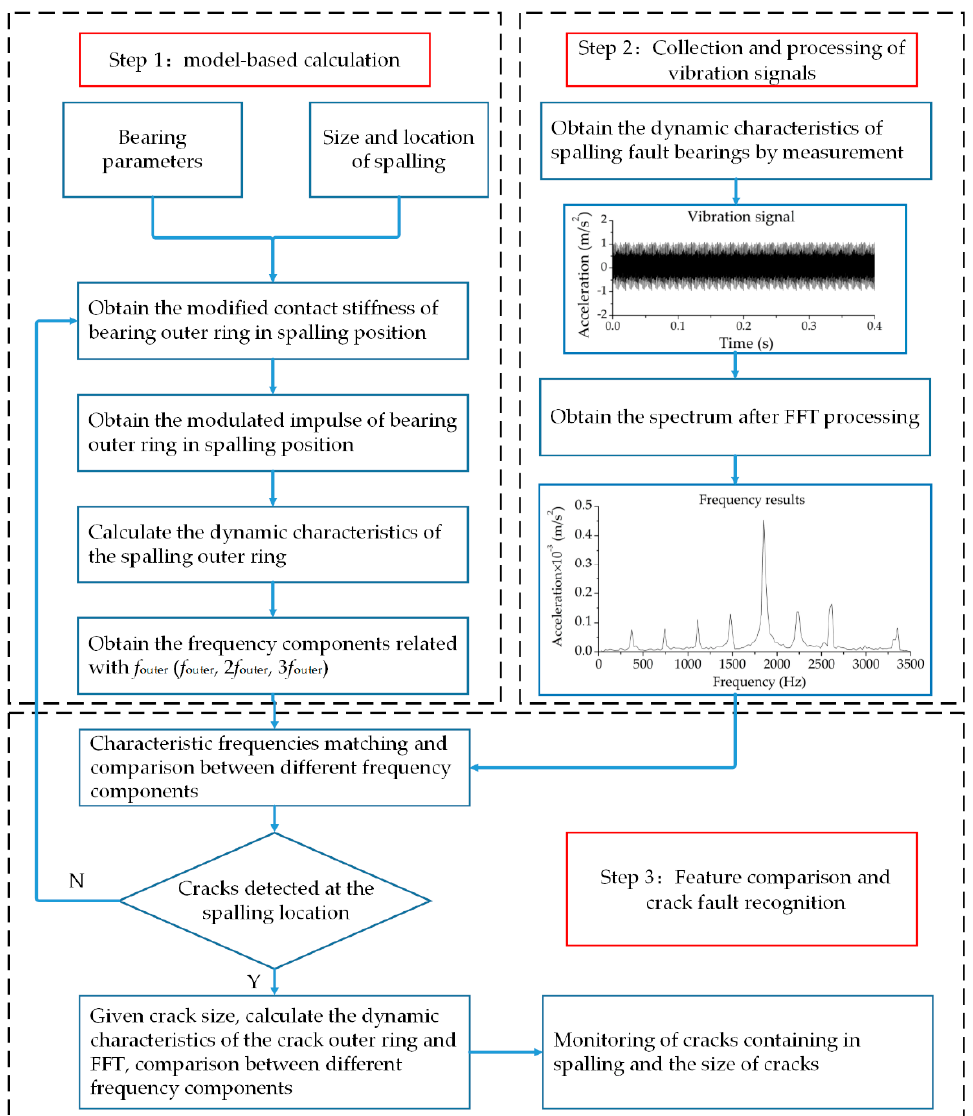
Figure 7. Flow chart of spalling position crack monitoring for full ceramic bearing outer ring.